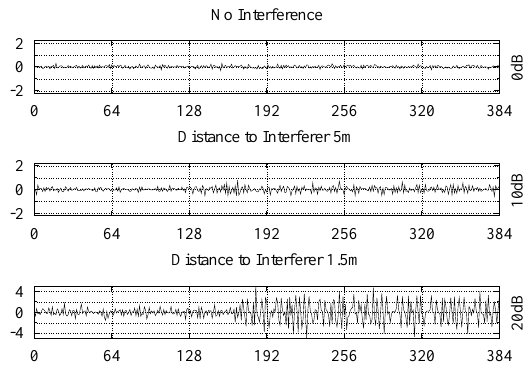
Figure 9. Extracted influence of interference Inf ( t ) for 384 demodulated chips for different distances between cognitive receiver and interferer